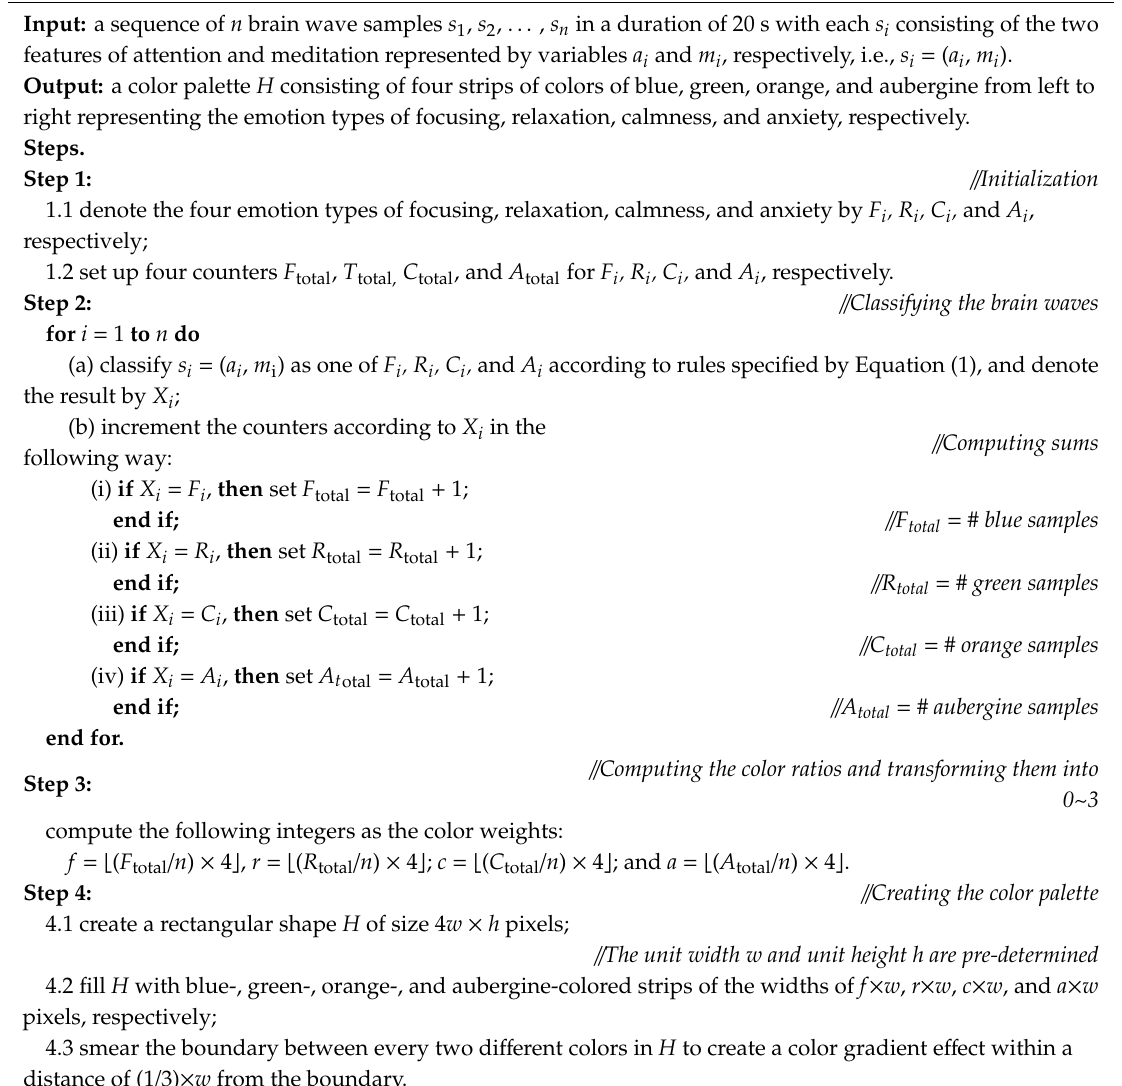
Algorithm 1 Generation of a color